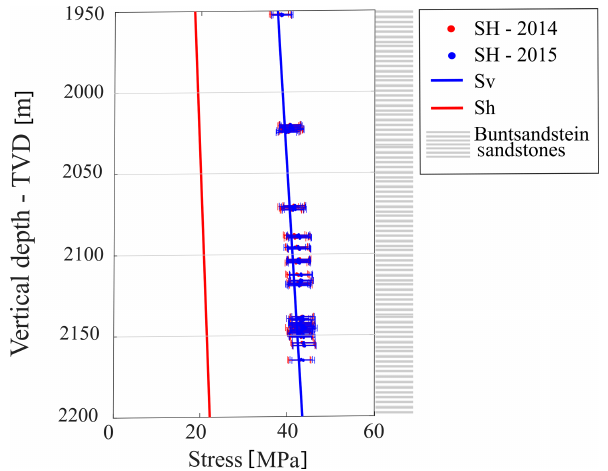
Figure 17. In situ stress components S h , S v and S H (MPa) in the de- viated well GRT-2. S H stresses are inverted using a Mohr–Coulomb failure criterion and represented as a function of vertical depth (TVD) for the images acquired in 2014 and 2015. Error bars are cal- culated considering the errors on the measurements of the breakout widths, on the elastic parameters, and on the S h and S v trends. The right column illustrates the lithological unit retained in the